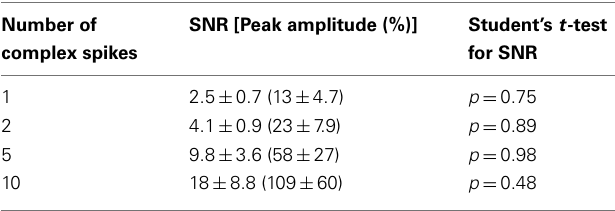
Table 5 | Responses ofYC2.60 in cerebellar Purkinje cells from older